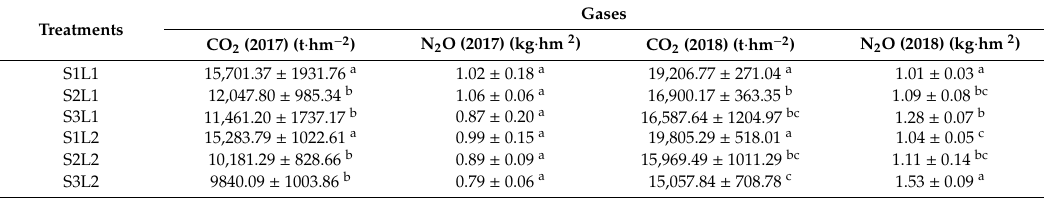
Table 2. Cumulative greenhouse gas emission under di ff erent treatments